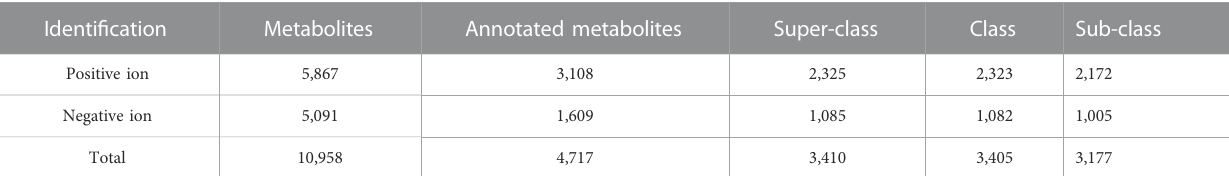
TABLE 1 Basic information of the cochlear metabolomics of the two echolocating bats.